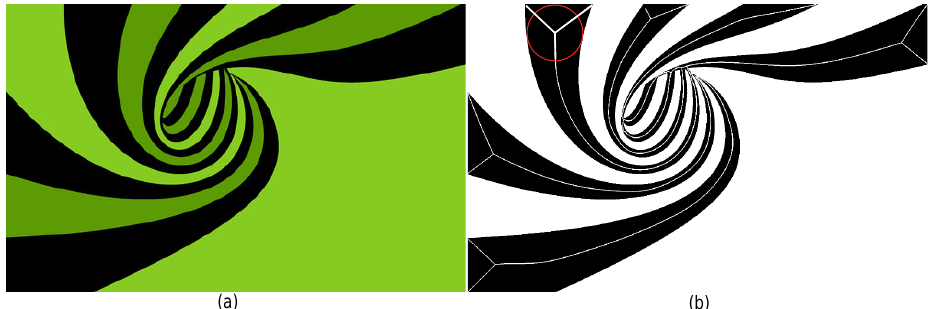
Figure 6. ( a ) Spiral shape image. ( b ) One of its threshold-sets T ↑ skeleton S (white). A Y-like structure (bold white) and the medial circle (in red) of a Y-junction are T ↑ 128 also shown in ( b